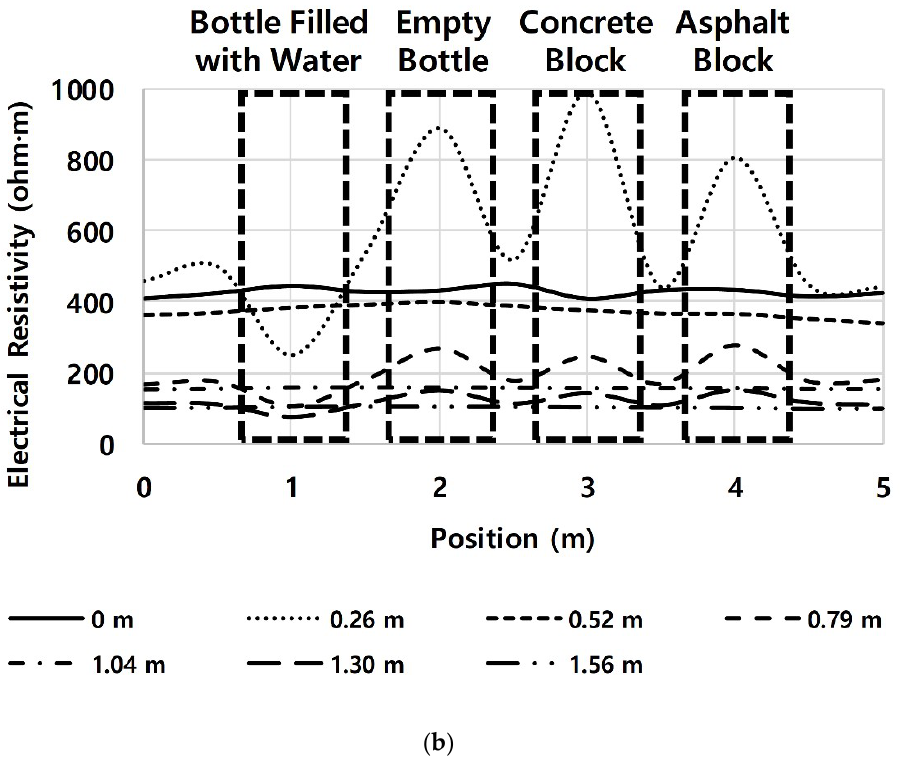
Figure 9. Test result for the underground facilities (Section No. 5); ( a ) Distribution of the ER. ( b ) ER according to the position at each depth.